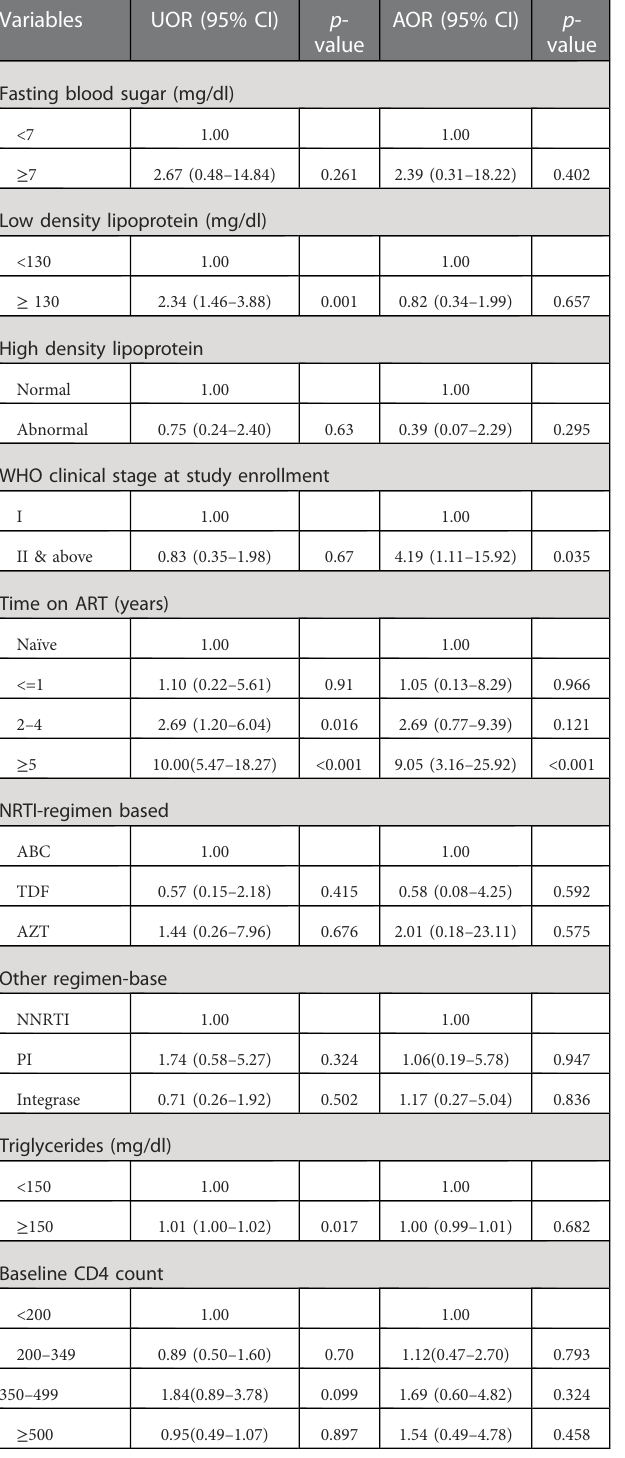
TABLE 5 Crude and adjusted associations of subclinical atherosclerosis and socio-demographics, and HIV-related characteristics (model